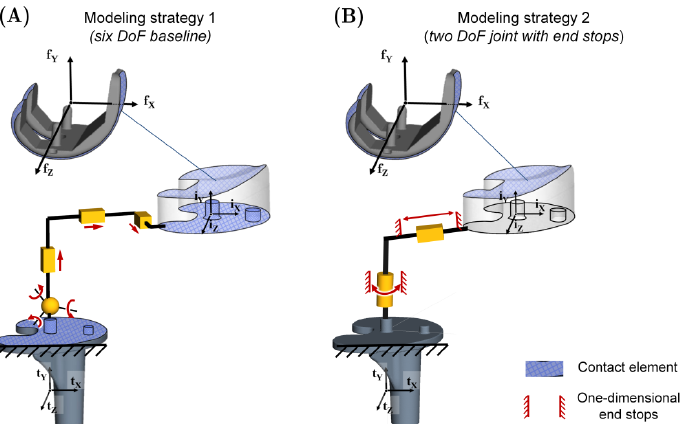
Figure 4. The interface between the tibial insert and the tibial tray of mobile-bearing (MB) design variants was modeled using two different modeling strategies. Exemplarily representation of the implant components and the coordinate systems for the femoral component f, tibial insert i, and tibial tray t. Depiction of the modeling strategy 1 ( A ) and 2 ( B ) as well as the corresponding degrees-of-freedom (DoF) between the tibial insert and tibial tray for the three MB design variants.